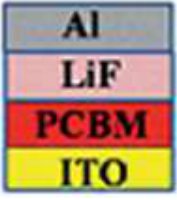
Figure 1. Molecular structure of the applied chemical materials. ( a ) PCBM; ( b ) CB; ( c ) NMP; ( d ) DMSO; ( e ) DMF; ( f ) AC; ( g ) DCE.